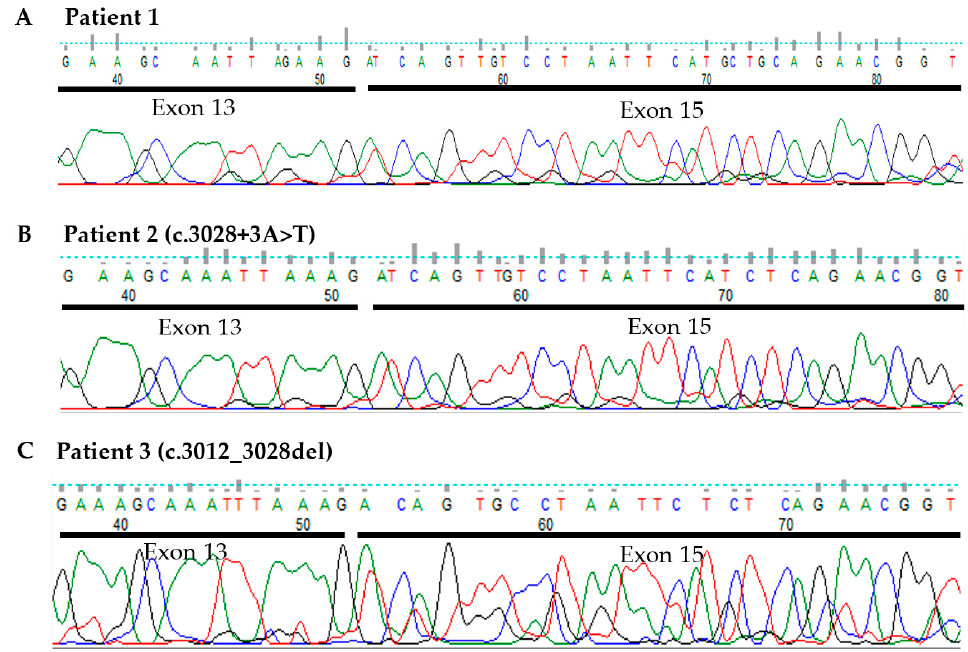
Figure 3. Sanger sequencing on PCR products obtained from Bioanalyzer polyacrylamide gel. Exon 13 and 15 sequences are indicated with black bars. ( A ) Negative patient control with 260 bp PCR product. ( B ) Patient 1 with MET c.3028+3A>T variant, 119 bp product. ( C ) Patient 1 with MET c.3028+3A>T variant, 119 bp product. Patient 3 with MET c.3012_3028del, 119 bp product.